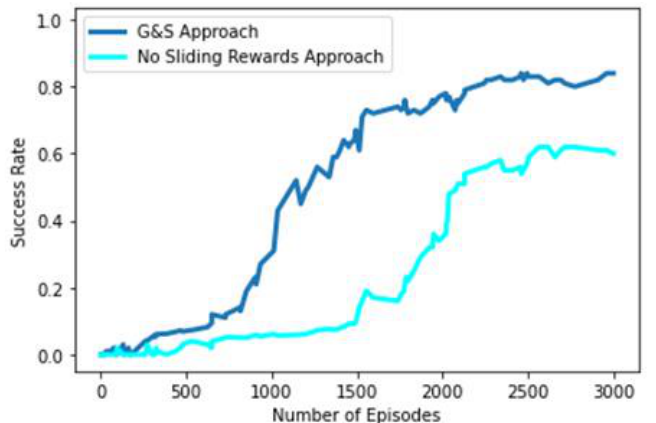
Figure 14. Performance comparison of original G&S approach and no-sliding-rewards